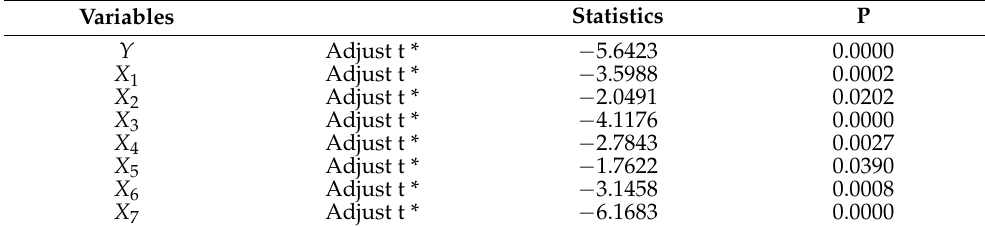
Table 3. Unit root test